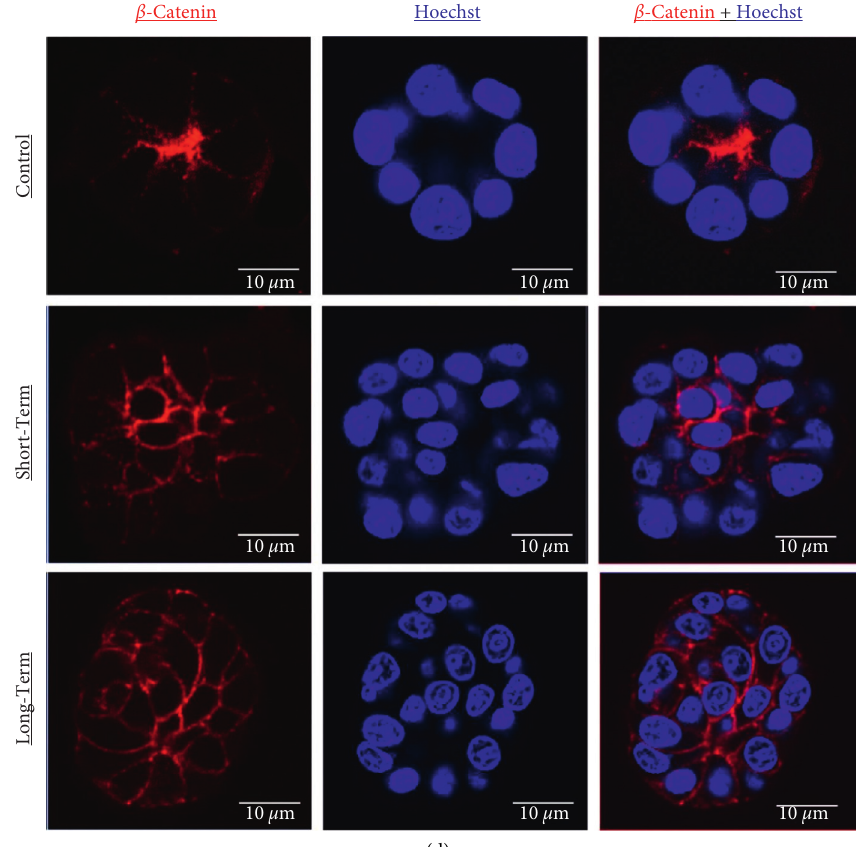
Figure 5: Endotoxin disrupts lumen formation in 3D cultures of human breast epithelial S1 cells. Acini of (a) control untreated S1 cells (0 μ g/ml) and (b) S1 cells subjected to long-term ETtreatment at 10 μ g/ml were stained with Hoechst (blue) on day 11 and scored for lumen formation. White arrows point at acini with normal monolayered lumen, while red arrows point at those with disrupted multilayered lumen. (c) Bar graph shows percentages of acini with undisrupted monolayered lumen in control untreated S1 cells and those subjected to short- term as well as long-term ETtreatment at 10 μ g/ml. One hundred acini were scored for each condition in every replicate. Each bar represents triplicate analyses of mean ± SD. ∗∗ P < 0 . 01 compared to the untreated control. (d) Representative S1 acini immunostained for β -catenin (red) and counterstained with Hoechst (blue). The upper lane shows a control untreated S1 acinus with undisrupted monolayered lumen and apicolateral β -catenin localization. The middle lane shows an S1 acinus following short-term ET treatment at 10 μ g/ml, and the lower lane shows an S1 acinus following long-term ETtreatment at 10 μ g/ml. Both short-term and long-term treatments reveal higher abundance of multilayered acini devoid of lumen, with relocalization of β -catenin across the entire cell